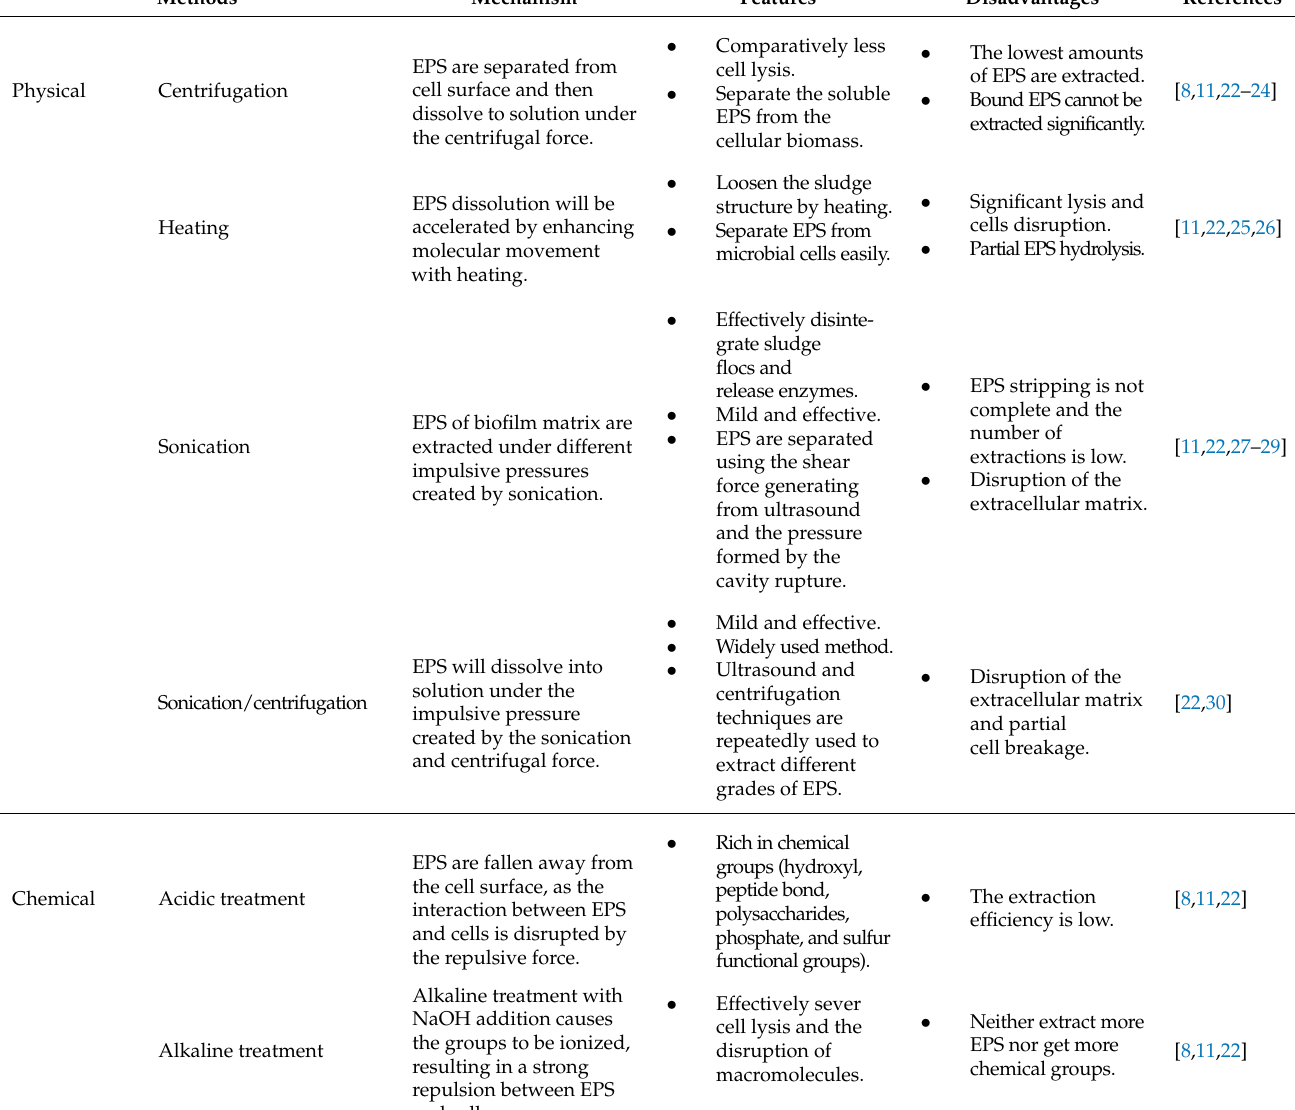
Table 1. Different TB-EPS extraction